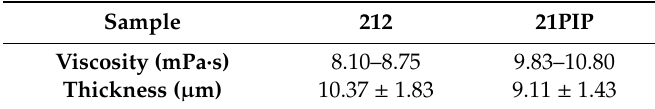
Table 3. Viscosity and thickness values of the 212 and 212P Table 3 . Viscosity and thickness values of the 212 and 212P samples.